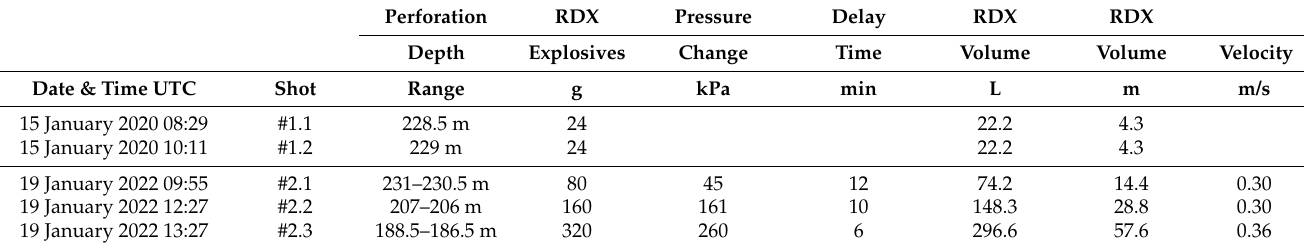
Table 2. Depth ranges and amount of explosives used during the perforation attempts. “RDX volume m” refers to the length of the borehole occupied by the expanded gas.